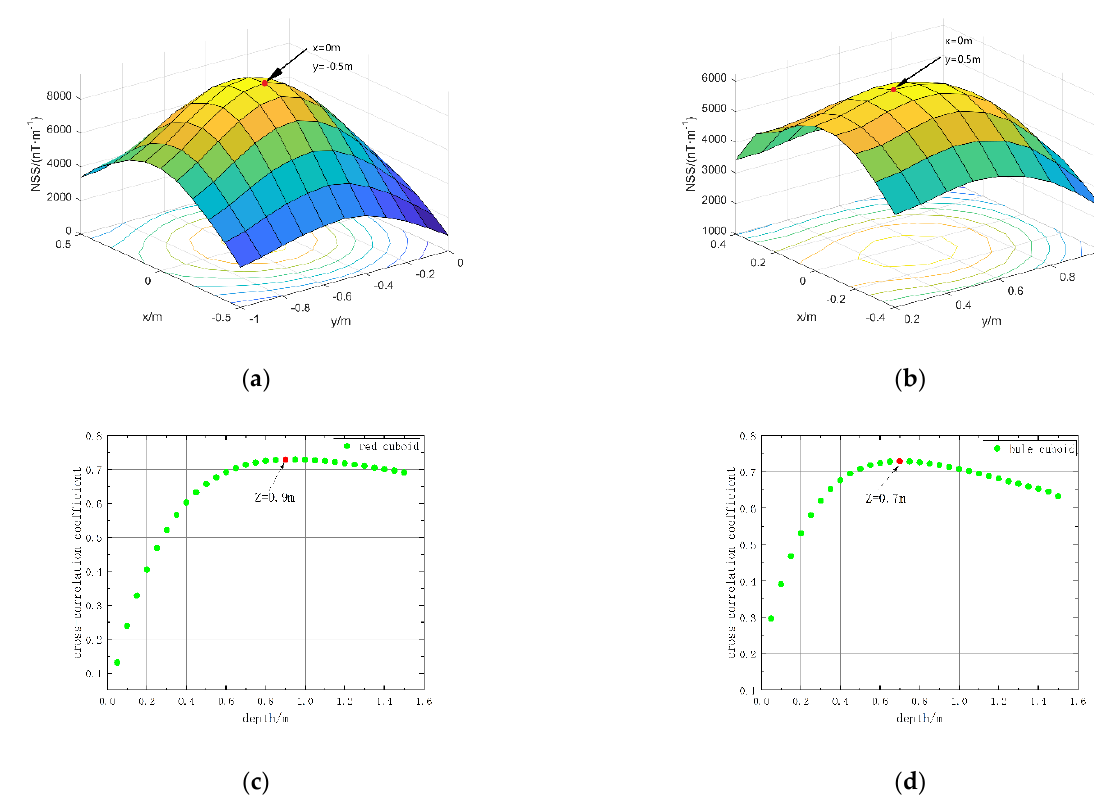
Figure 5. Estimated results of the center position of the simulation model: ( a ) Horizontal position of the red cuboid; ( b ) horizontal position of the blue cuboid; ( c ) the red cuboid depth; ( d ) the blue cuboid depth. Table 3. The center position estimation result and absolute error.